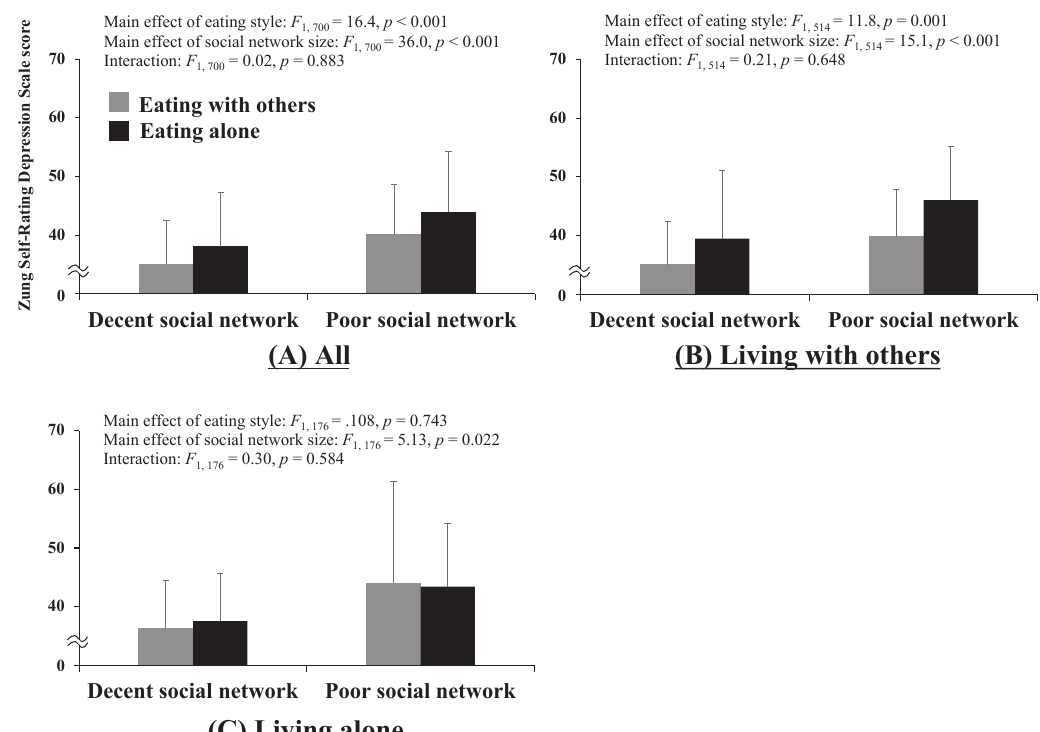
Figure 1. Zung Self-Rating Depression Scale score comparisons by eating style and social network size among (A) all participants, (B) participants living with others, and (C) participants living alone. Each analysis of covariance was adjusted for gender, age, education level, subjective health, subjective fi nancial situation, and numbers of medications and